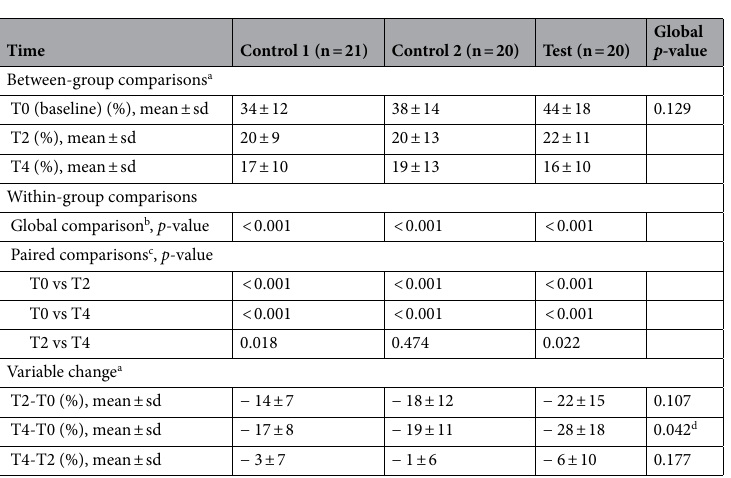
Table 2. Bleeding on probing results over time in three study groups: baseline, 2-month, and 4-month follow-up. a ANOVA was used for between-groups and variable change comparisons (three groups). If p -value < 0.05, post-hoc paired comparisons (with Bonferroni’s method) were also performed (depicted in footnote d). b For intra-group comparisons (three times), Friedman’s test was used. c Student’s T-test for paired samples. d Post-hoc paired comparisons for independent groups: Significant difference between Test